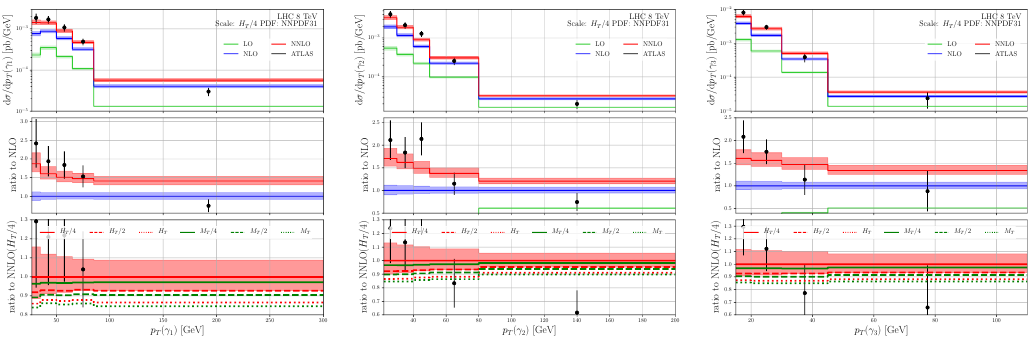
Figure 2 . p T distribution of the hardest photon (cid:13) 1 (left), (cid:13) 2 (center) and the softest one (cid:13) 3 (right). Top plot shows the absolute distribution at NNLO (red), NLO (blue) and LO (green) versus ATLAS data (black). Middle plot shows same distributions but normalized to the NLO. Bottom plot shows central NNLO predictions for 6 di(cid:11)erent scale choices (only the central scale is shown) with respect to the default choice (cid:22) 0 = H T = 4. The bands represent the 7-point scale variations about the corresponding central